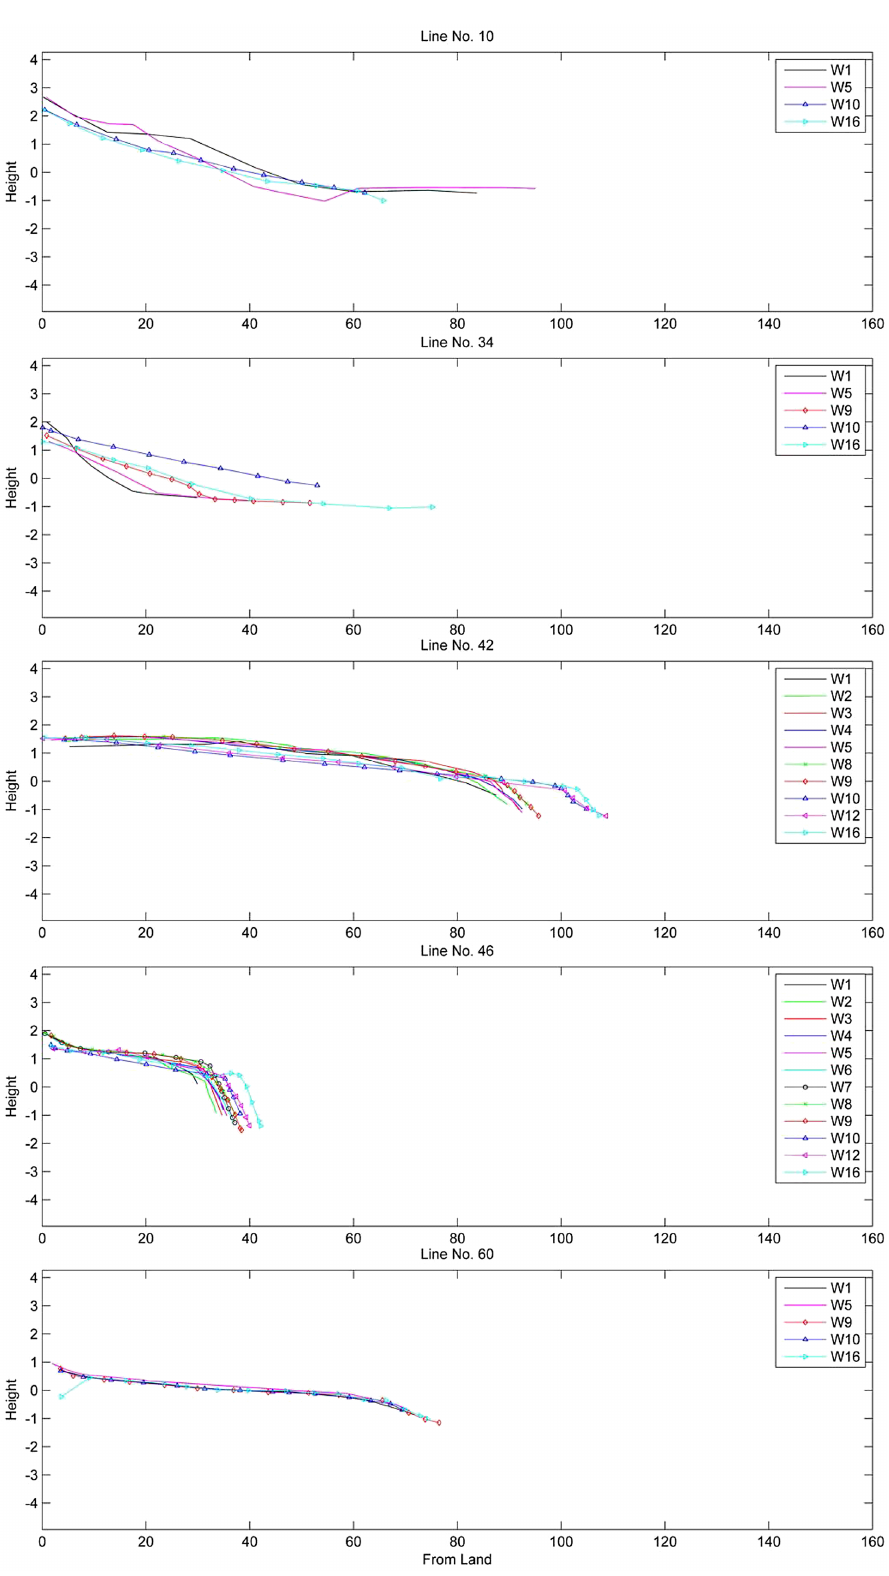
Fig. 8. Survey of the beach profile evolution for Line no. 10, 34, 42, 46 and 60. (All dimensions in